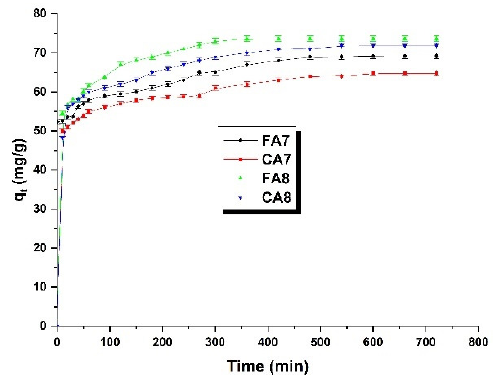
Figure 6. The effect of contact time of biocarbon with methyl red sodium salt (biocarbon mass: 25 mg, initial dye solution concentration: 40 mg/L, volume of methyl red sodium salt solution: 50 mL, temperature: 23 ± 1 °C). Table 5. Kinetic models